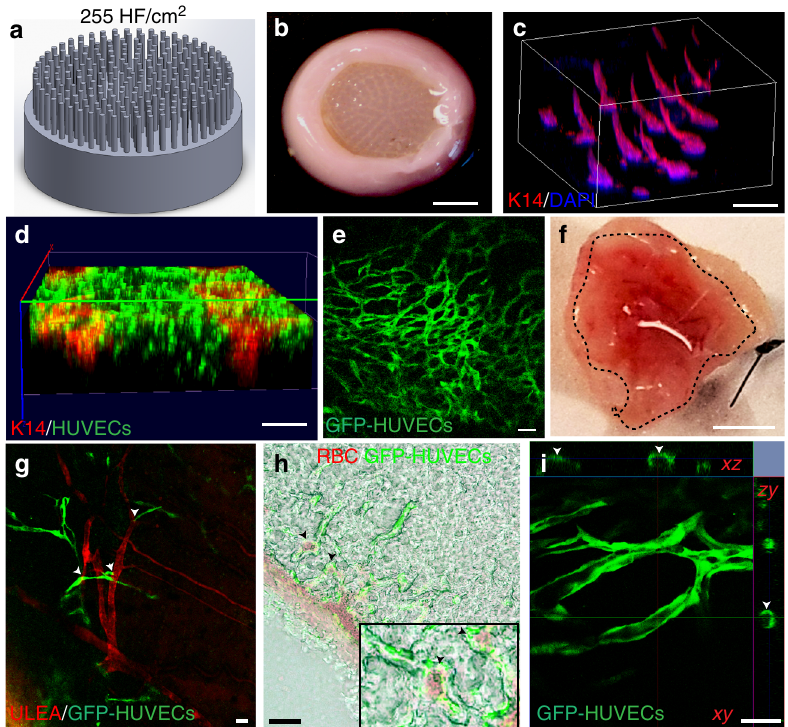
Fig. 4 Vascularization of high hair-follicle-density HSCs for ef fi cient engraftment. a , b HSCs were generated using the molds that have 255 HF per cm 2 to promote hair growth in grafts. c 3D-reconstructed wholemount image of the HSCs showing 3D conformation of K14-positive cells at the high hair follicle density. GFP-tagged HUVECs that were encapsulated in the dermal compartment with the fi broblasts closely surrounded the K14-positive cells in the hair follicle structures ( d ) and formed capillary-like networks after 3 days of culture ( e ). f Bottom view of the explanted prevascularized HSCs (dashed circle) with GFP-HUVECs showing promoted host vascularization and blood supply to the grafts ( n = 9; three technical and three biological replicates); g HSCs grafted onto mice were revascularized by the host vessels where GFP-tagged HUVECs (green) formed capillaries that are well-organized around the mouse vessels ( GS - IB 4 staining in red; arrow heads show the proximity of mouse and human vessels) and red blood cells (RBCs) ( h ), (arrow heads show host RBCs near human blood vessels and lower panel shows a magni fi ed area of the image); and exhibited lumen formation (arrow heads show the lumen) ( i ). Scale bars for ( b and f ), ( c , d ), and ( e , g , h and i ) are 4 mm, 2 mm, and 100 µ m,